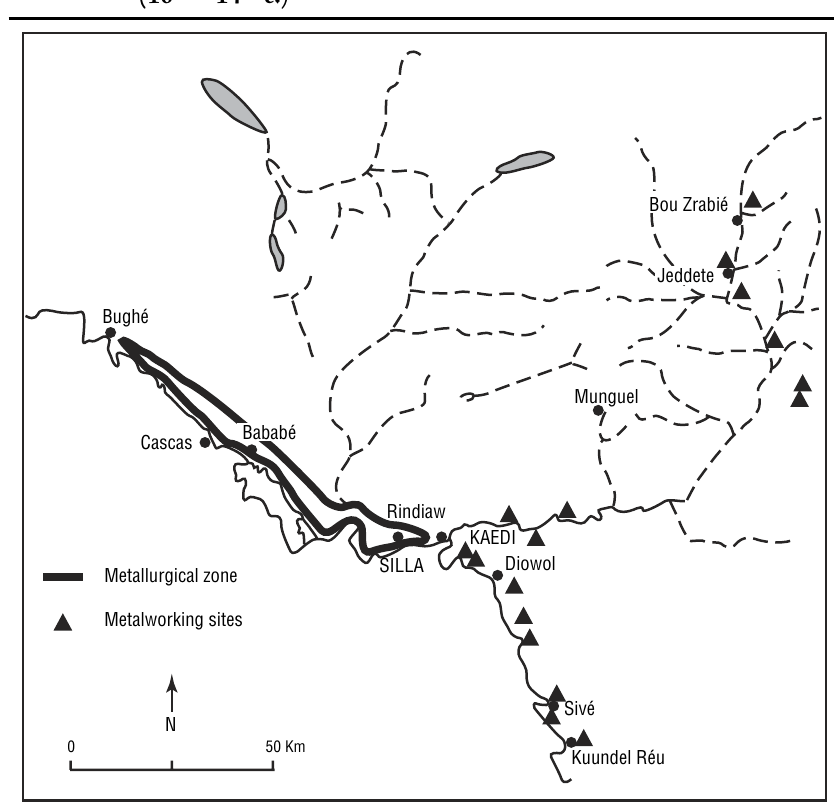
Figure 21 – Metalworking Centers in the Middle Senegal Valley